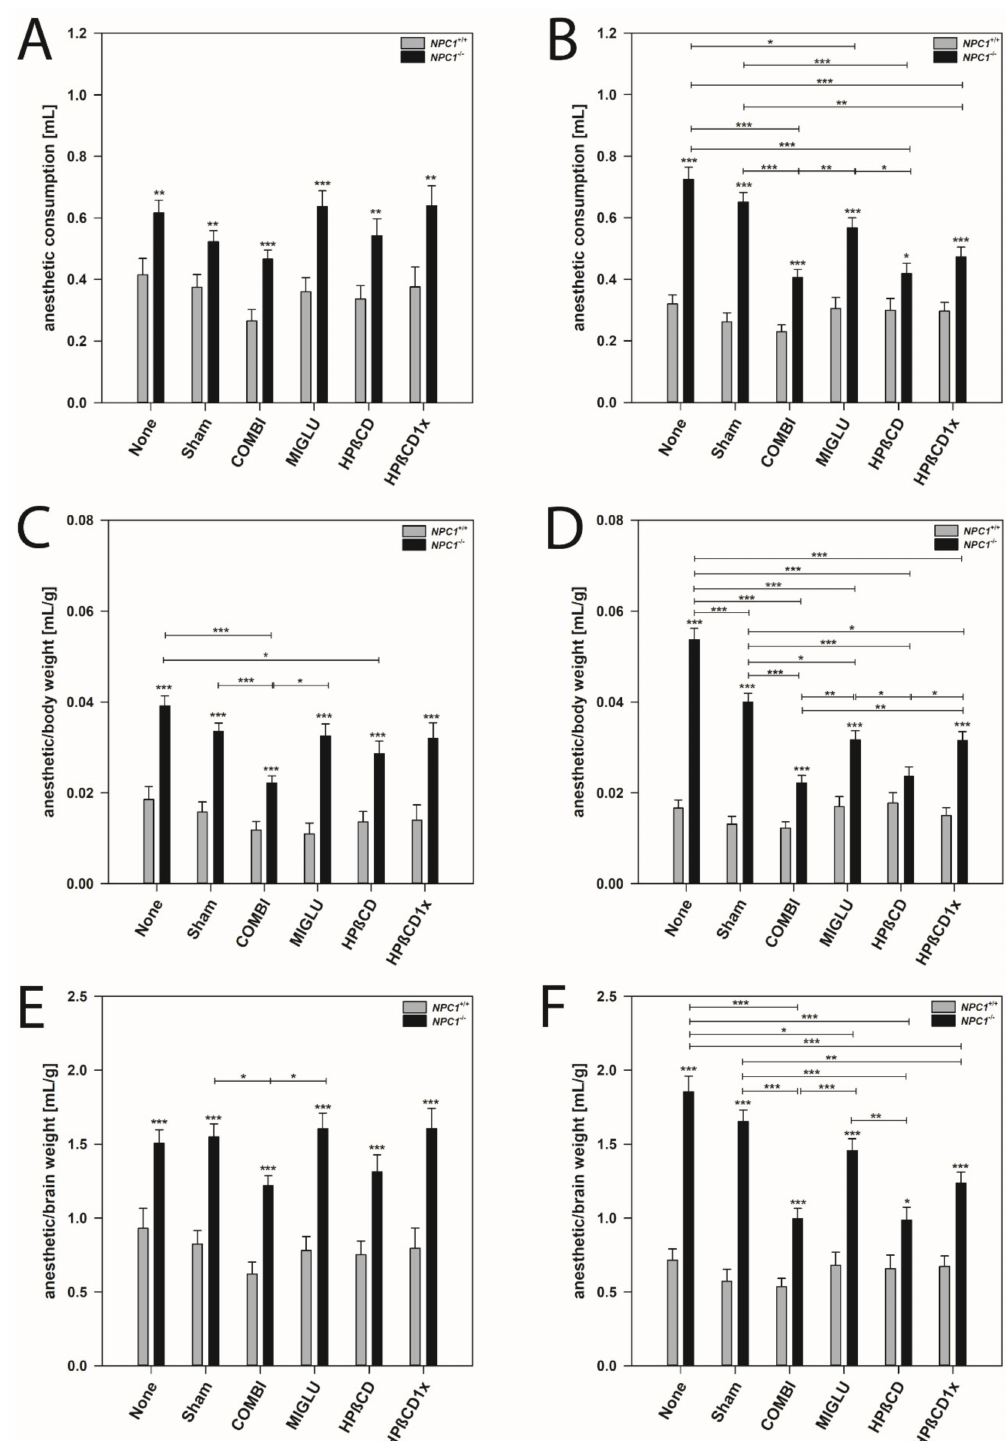
Figure 3. Anesthetic consumption ( A , B ), anesthetic consumption/body weight ( C , D ) and anesthetic consumption/brain weight ( E , F ) of NPC1 mice. Male ( A , C , E ) and female ( B , D , F ) NPC1 mice. Significant post-hoc tests are indicated by asterisks (* p < 0.05, ** p < 0.01, *** p < 0.001). Data are means ± SEM. 2.5. Anesthetic Consumption Related to Body Weight Male mice: In all groups of NPC1 +/+ mice, the ratio of the amount of anesthetic mixture and body weight was relatively constant (mean 0.0142 mL/g) (Figure 3C). Compared to the None and Sham groups of the NPC1 − / − mice (means 0.0392